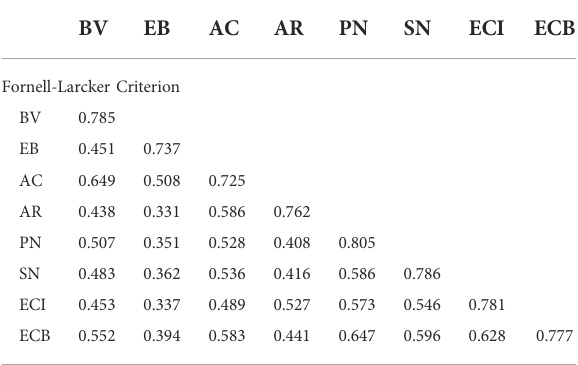
TABLE 4 Discriminant